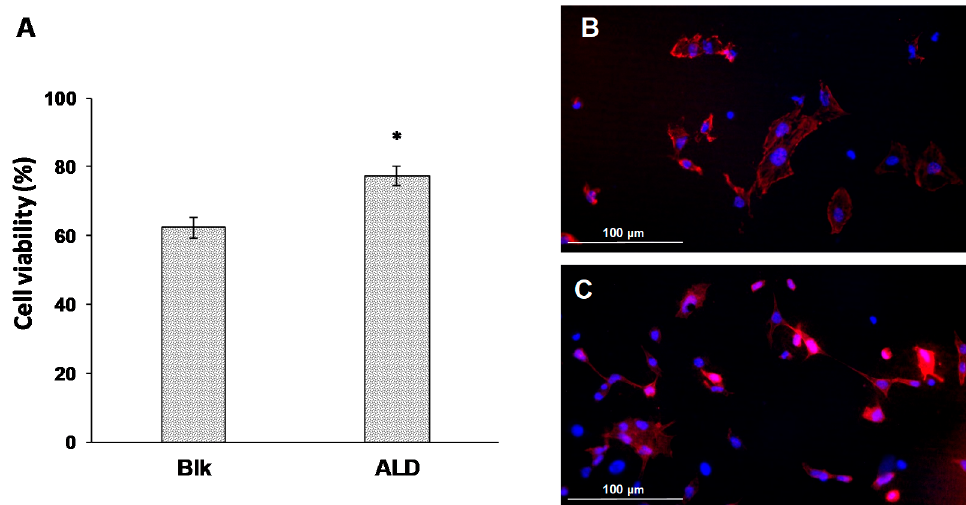
Figure 7. ( A ) Cell viability relative to control (polystyrene plate) of OP mMSC cultured on plasma-treated electrospun meshes containing covalently linked ALD or not and cell morphology of OP mMSC cultured on ( B ) ALD-linked electrospun meshes or ( C ) blk electrospun meshes. Blank (blk) stands for meshes without ALD. (*) denotes statistical significance differences compared with non-OP group (control) p < 0.001.